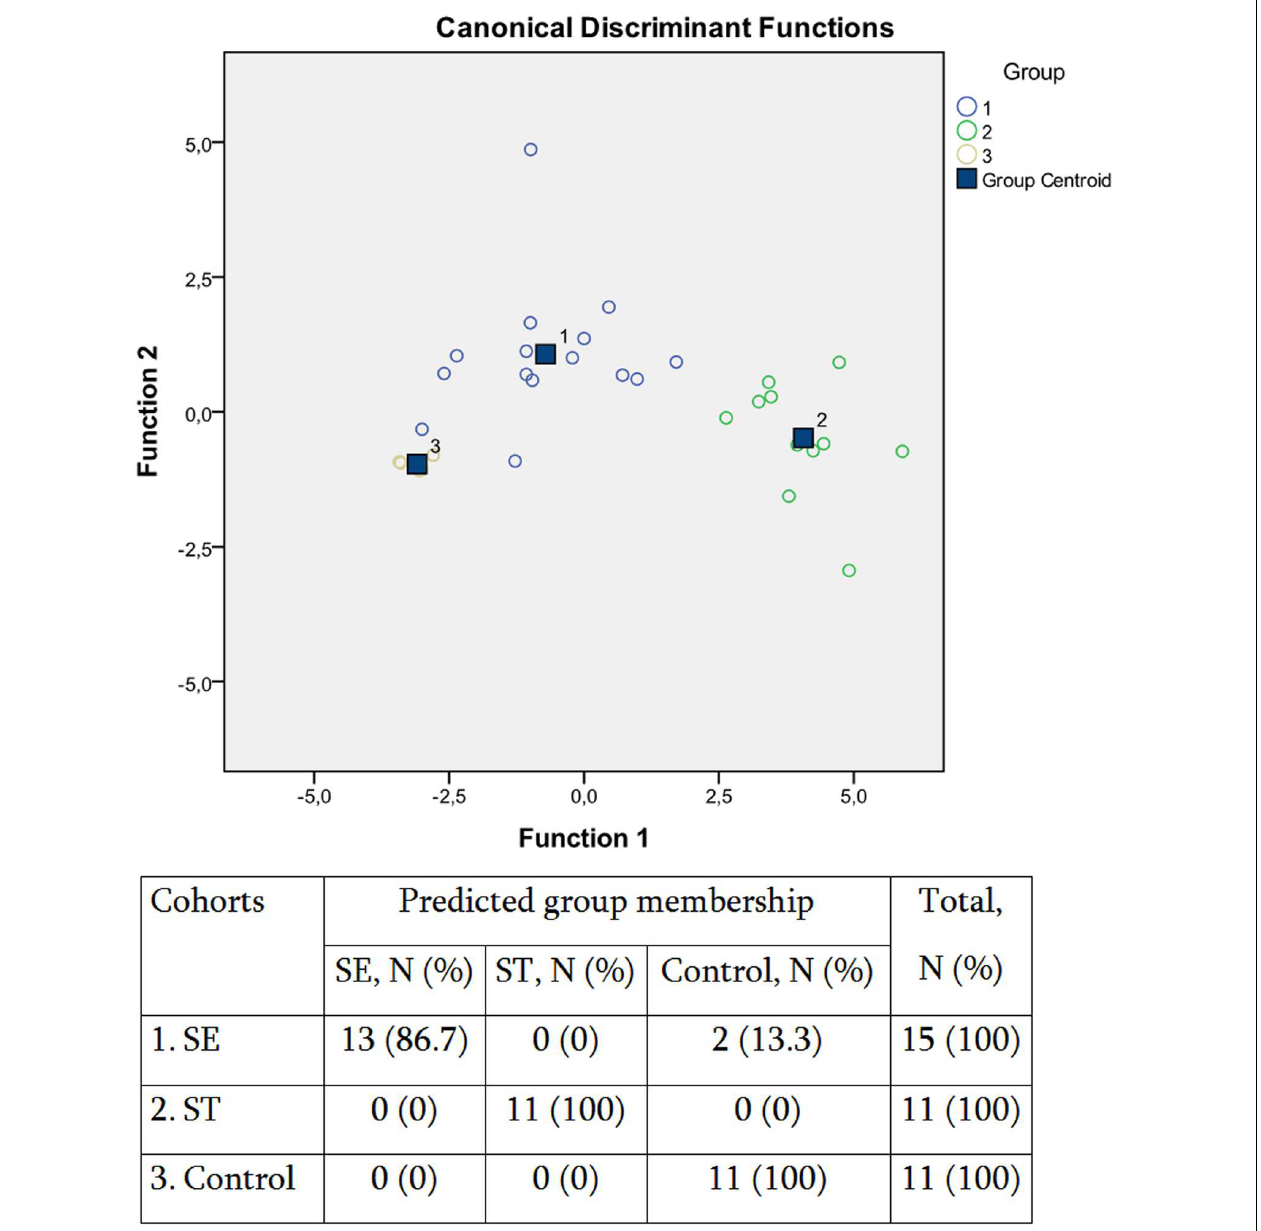
FIGURE 2 | Scatterplot of DA model and the predicted group membership in the model based on systemic concentration of microbial SCFAs in salmonellosis patients and control subjects. Number of variables in the model – 8 and grouping consists of three groups. Root 1, 2 – discriminant functions 1 and 2 (1st and 2nd canonical roots). Cohorts: (1) S . Enteritidis-infected patients (SE), (2) S . Typhimurium-infected patients (ST), (3) control subjects. Predictive accuracy of classification: 94.7% of the original group cases were correctly classified; Wilks’ λ =